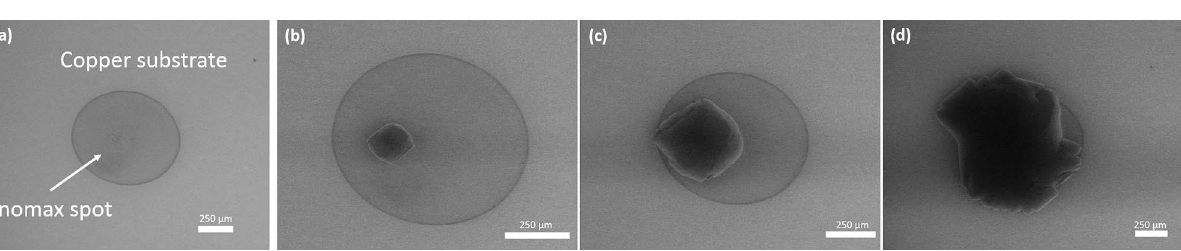
Figure 6. ( a ) Snomax spot on the copper substrate at the condition P = 102 Pa and T = − 20 °C (h ice < 1) where no ice condensation is observed. ( b – d ) Time series of observing a Snomax spot. Ice growth is triggered on the spot at the condition P = 119 Pa, h ice = 1.05 and h SCW = 0.94. Figures b–d are images captured during ice growth at ( b ) t = 0, c) t = 20 s, and d) t = 67